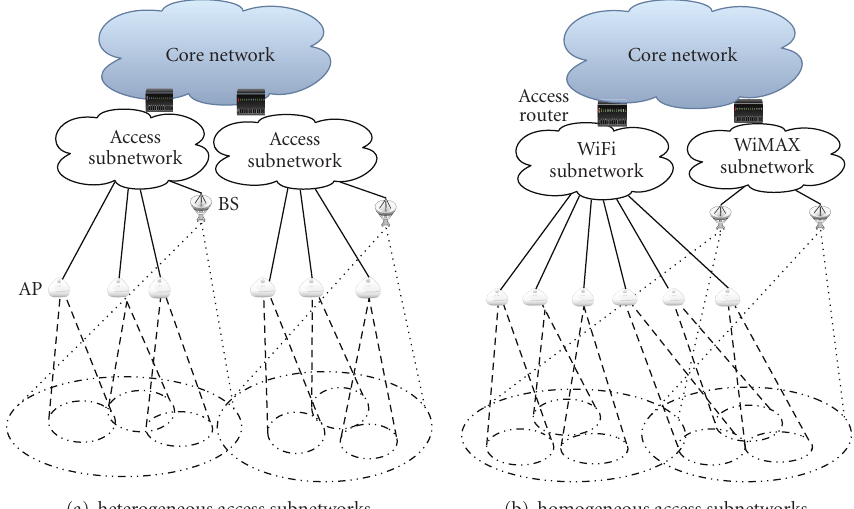
Figure 5: WiFi-WiMAX